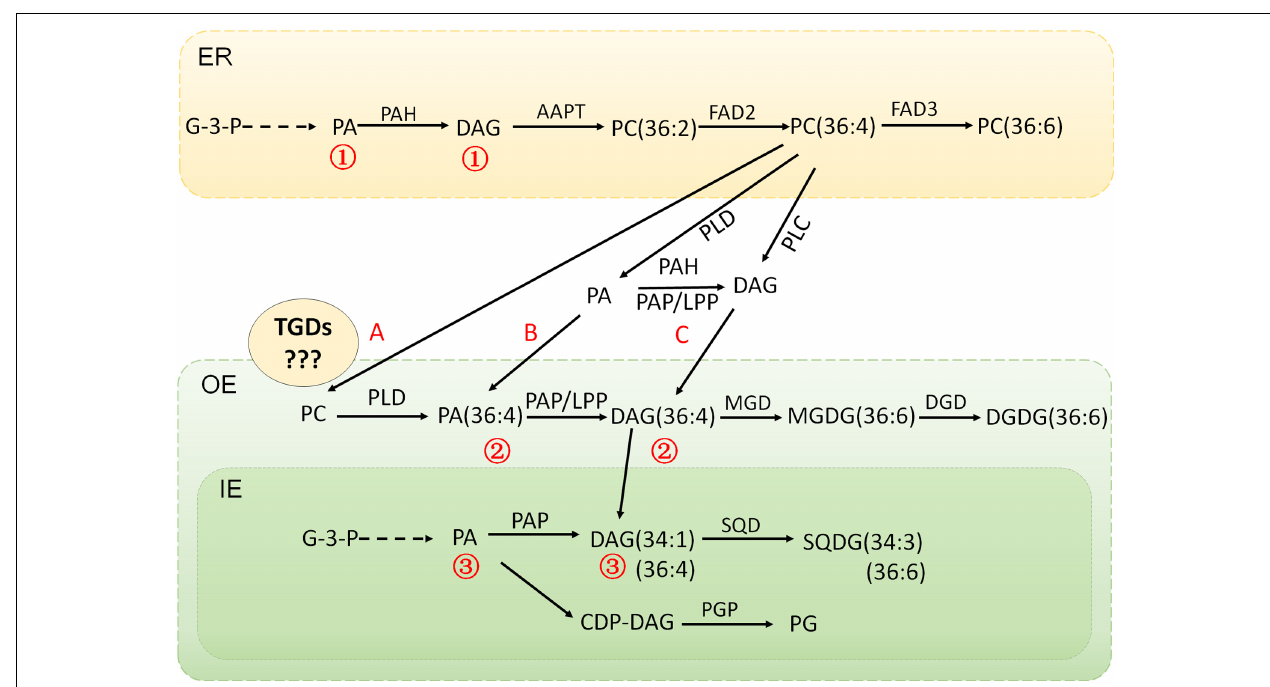
FIGURE 5 | The proposed interaction and intermediates exchange between phospholipids pathway and galactolipids pathway in maize under low temperature stress. The de novo assembly of PA and DAG in endoplasmic reticulum and plastid produced different PA and DAG pools (the ER localized were marked as (cid:172) , and plastid localized were marked as (cid:174) ) and PA and DAG generated from PC hydrolysis by phospholipases form a separated PA and DAG pool (marked as (cid:173) ). A, B, C represents the proposed routes for the lipids trafficking between ER and chloroplast. ER, endoplasmic reticulum; OE, outer envelope; IE, inner